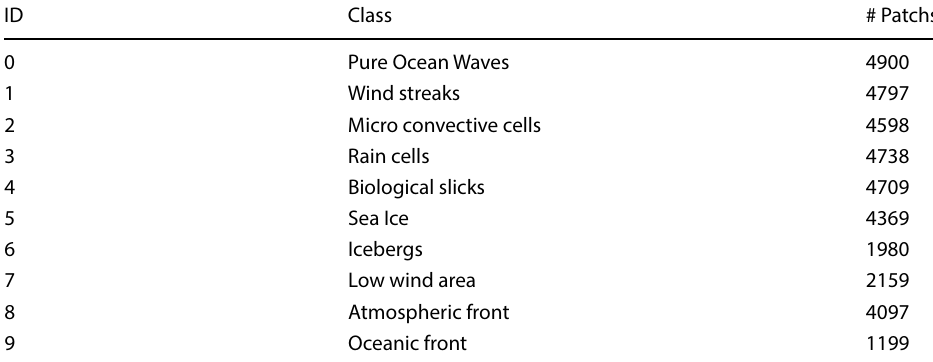
Table 1 Number of images per class in the TenGeoP- SARwv